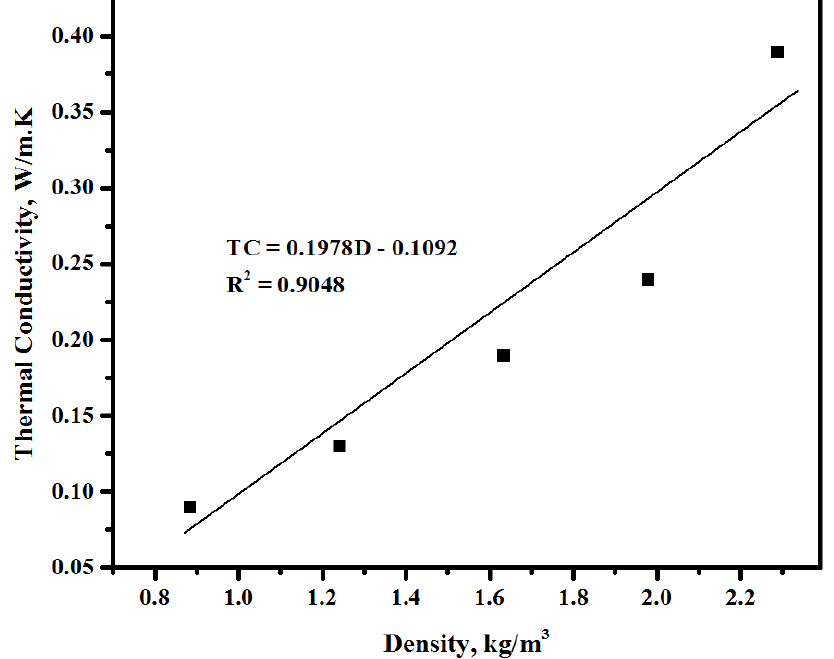
Figure 21. Relationship between the heat transfer time and the density of the prepared concretes.